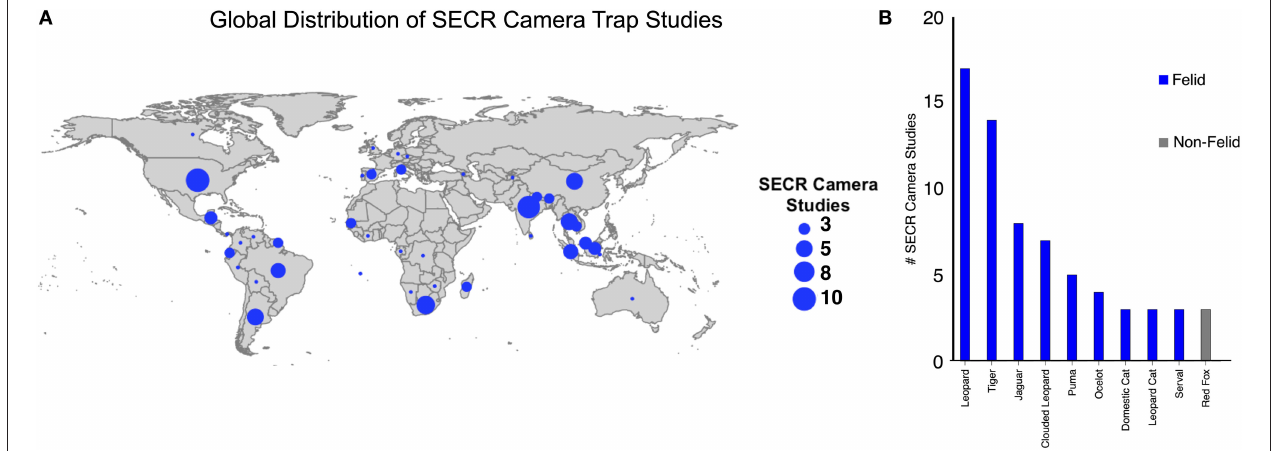
FIGURE 1 | Camera trap SECR study spatial distribution and species focus. (A) Global spatial distribution of camera trap SECR studies by country. (B) Number of studies focused on the top 10 focal species. The top 10 species listed accounted for 61% of all SECR camera trap studies. Most (75%) SECR camera trap studies focused on